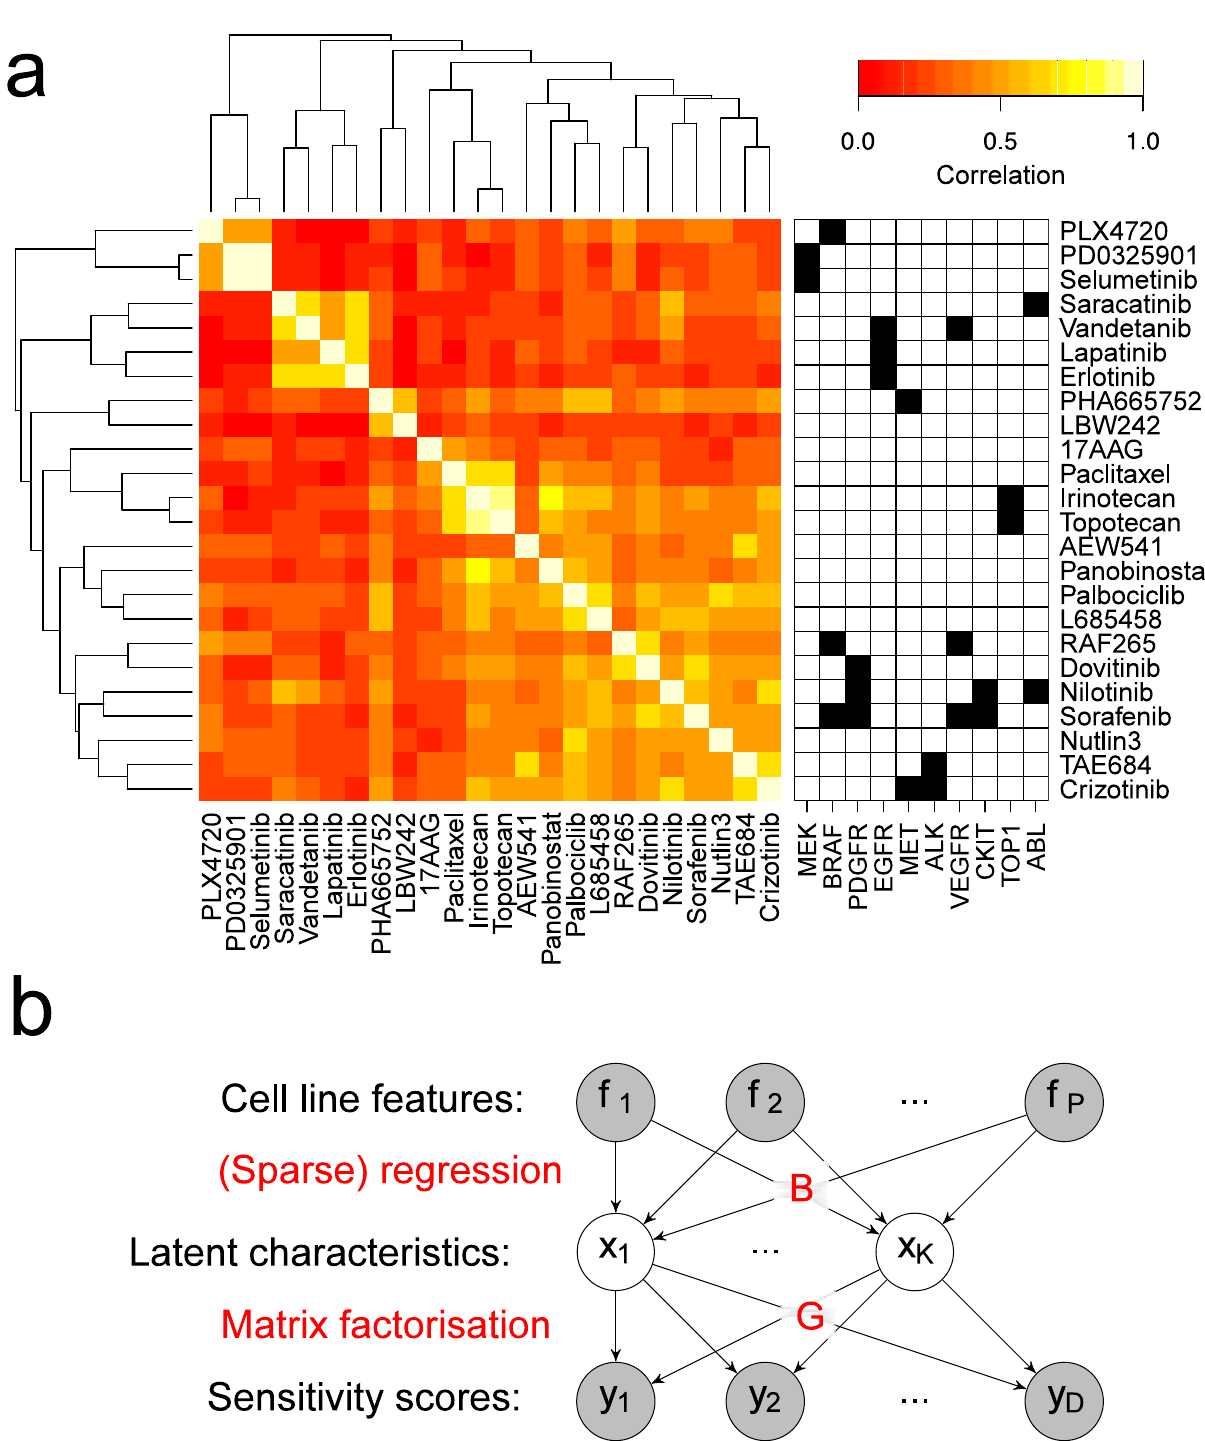
Fig 1. Joint analysis of cell line sensitivity across multiple drugs has the potential to improve predictive accuracy as well as model interpretability. a . While cancers are genetically heterogeneous there are phenotypic characteristics shared by many cancers subtypes, some of which are illustrated here. We refer to these as latent characteristics (LCs) because they are not directly observable from genomic data, but we hypothesize that each characteristic will have a detectable genetic signature and a defined influence on drug sensitivity. b . Pearson correlation of drug sensitivity profiles (active area scores) across CCLE, annotated by known inhibition targets. c The Lacrosse model consists of two components, shown here graphically. The first is a sparse linear regression from cell line features, F (gene expression, copy number variation and genomic mutations) to continuous valued latent characteristics, X . The second is a sparse factor analysis (matrix factorization) where the latent characteristics (the factors) explain the observed sensitivity scores through a sparse loading matrix G .